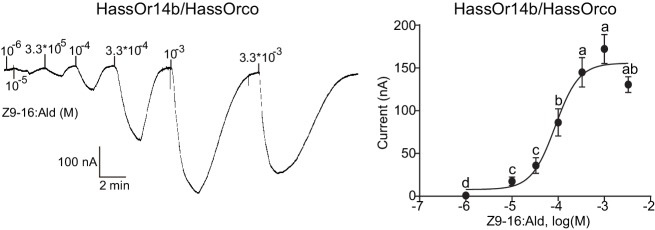
Dose responses of Xenopus oocytes with co-expressed HassOr14b/HassOrco stimulated with a range of Z9-16:Ald concentrations.Inward current responses (left) and response profiles (right) of Xenopus oocytes expressing HassOr14b/HassOrco in response to Z9-16:Ald at serial concentrations. The EC50 value for Z9-16:Ald was 8.65 × 10–5 M. n = 7–9 replicates of cells, F = 54.57, p<0.001, one-way ANOVA, Tukey HSD test.